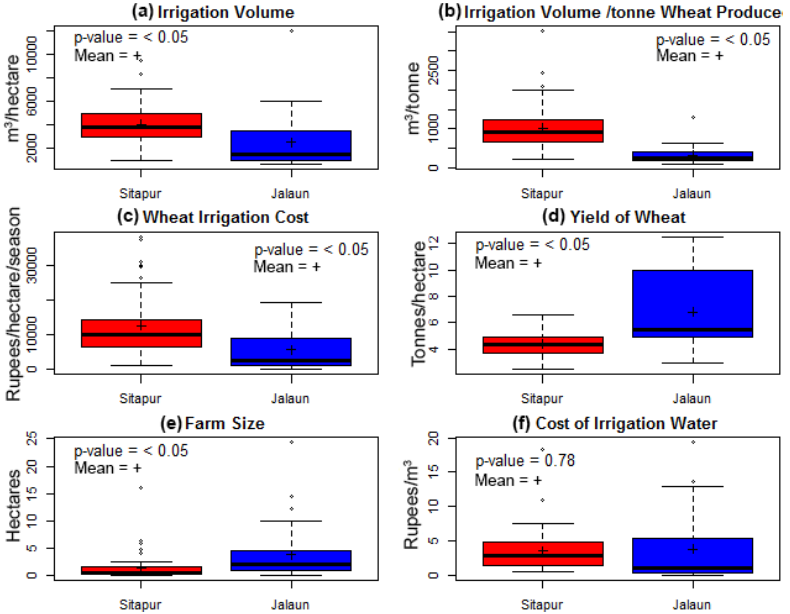
Figure 2. Differences in irrigation practices between the districts of Sitapur and Jalaun, Uttar Pradesh, northern India. The boxplots represent variability between farmers in each district. The boxes represent the 25 to 75 percentiles; the whiskers represent 1.5 times the interquartile range (IQR). The P values give the chance of equal mean obtained from Student’s t test.